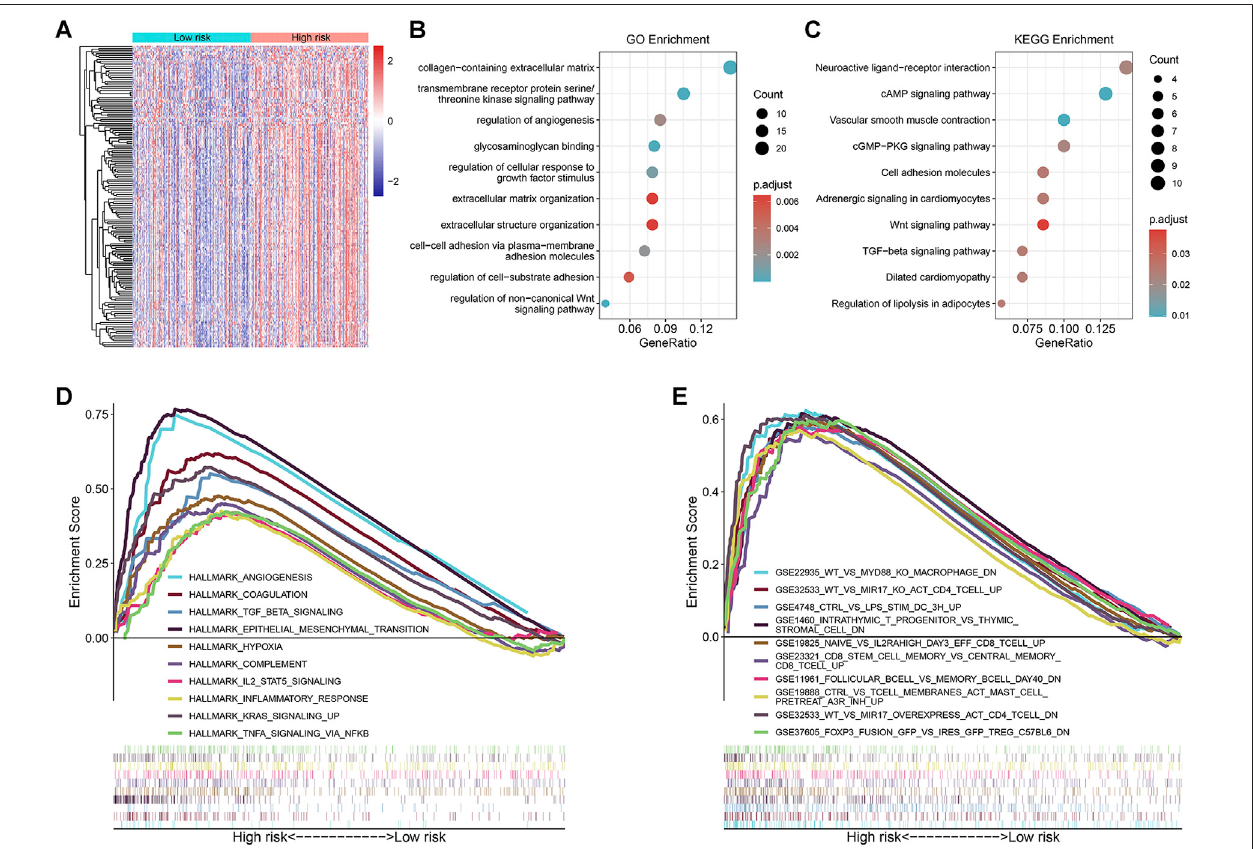
FIGURE4| Explorationoftheunderlyingmolecularmechanismsoftheprognosticsignature. (A) Heatmapofthedifferentiallyexpressedgenes(DEGs)betweenthe high-andlow-riskgroups; (B,C) Signi fi cantlyenrichedGeneOntology(GO)annotationsandKyotoEncyclopediaofGenesandGenomes(KEGG)pathwaysbyanalyzing the DEGsup-regulatedinthehigh-risk group; (D,E) Pre-ranked geneset enrichment analysis(GSEA) ofthe tumor hallmarks and immunologiccharacteristicscorrelated with the prognostic signature.